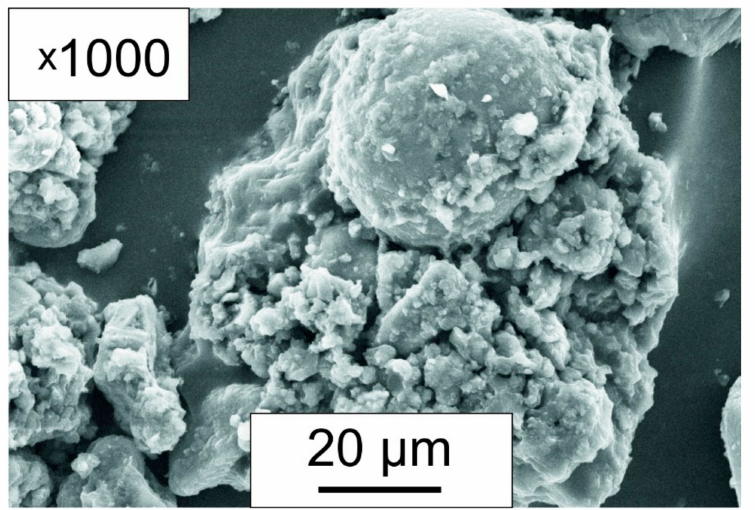
Figure 7. Micrograph of the semi-coke sample.